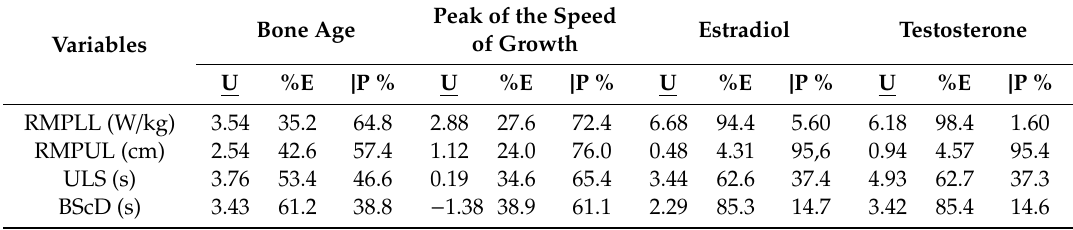
Table 6. Analysis of artificial neural networks perceptron for the probabilities of predictions. Peak of the Speed Bone Age Estradiol of Growth Variables